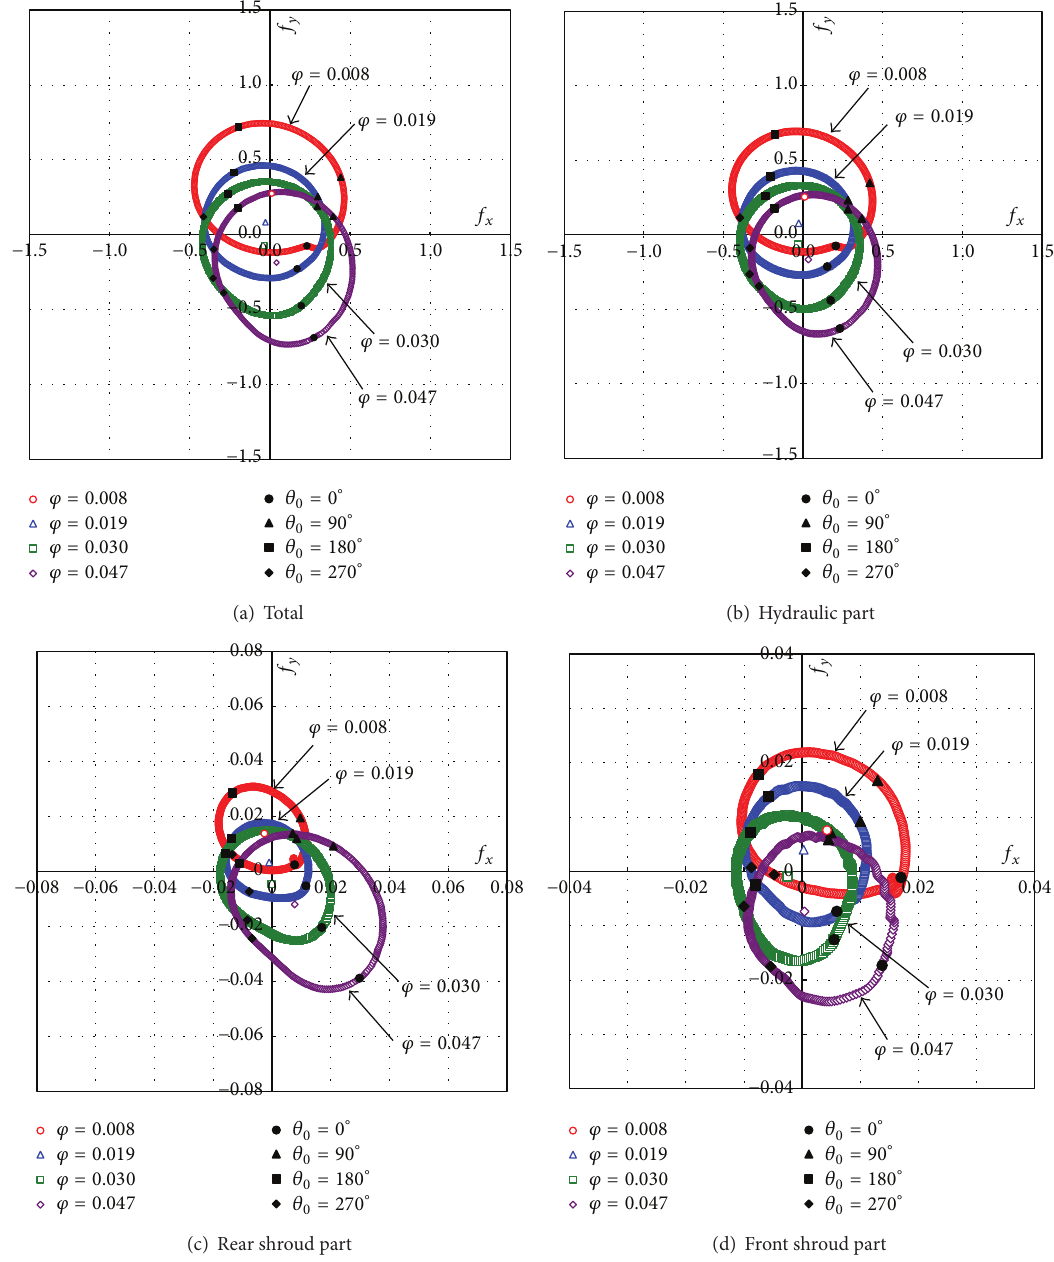
Figure 6: Lissajous figures of radial thrust coefficient on each part ( 𝛽 𝑏2 = 8